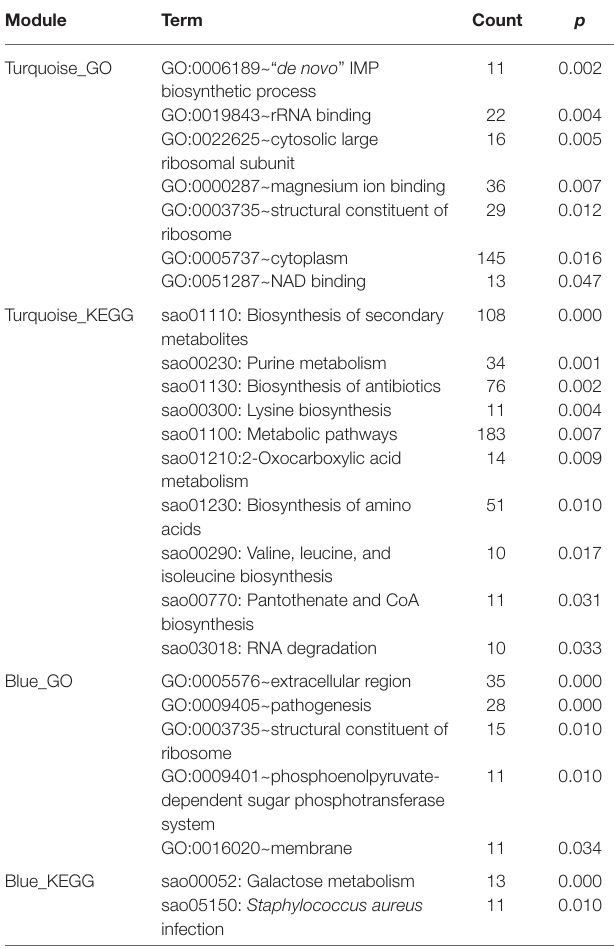
TABLE 3 | GO and KEGG enrichment analyses of module blue and turquoise constructed by WGCNA ( p < 0.05, count ≥ 10).